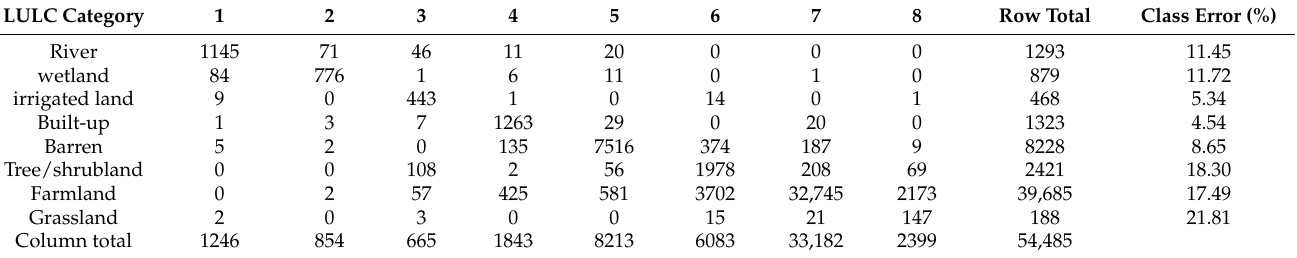
OOB confusion matrix for Sentinel-2 (Scenario 1) classification results.